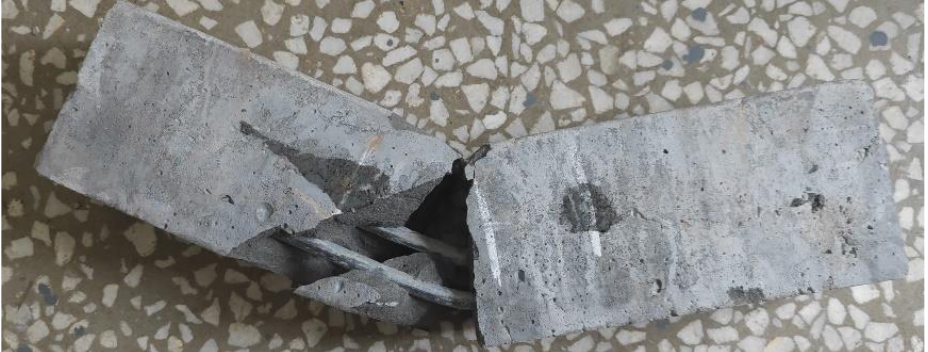
Figure 6. The failure state of SBRPC.